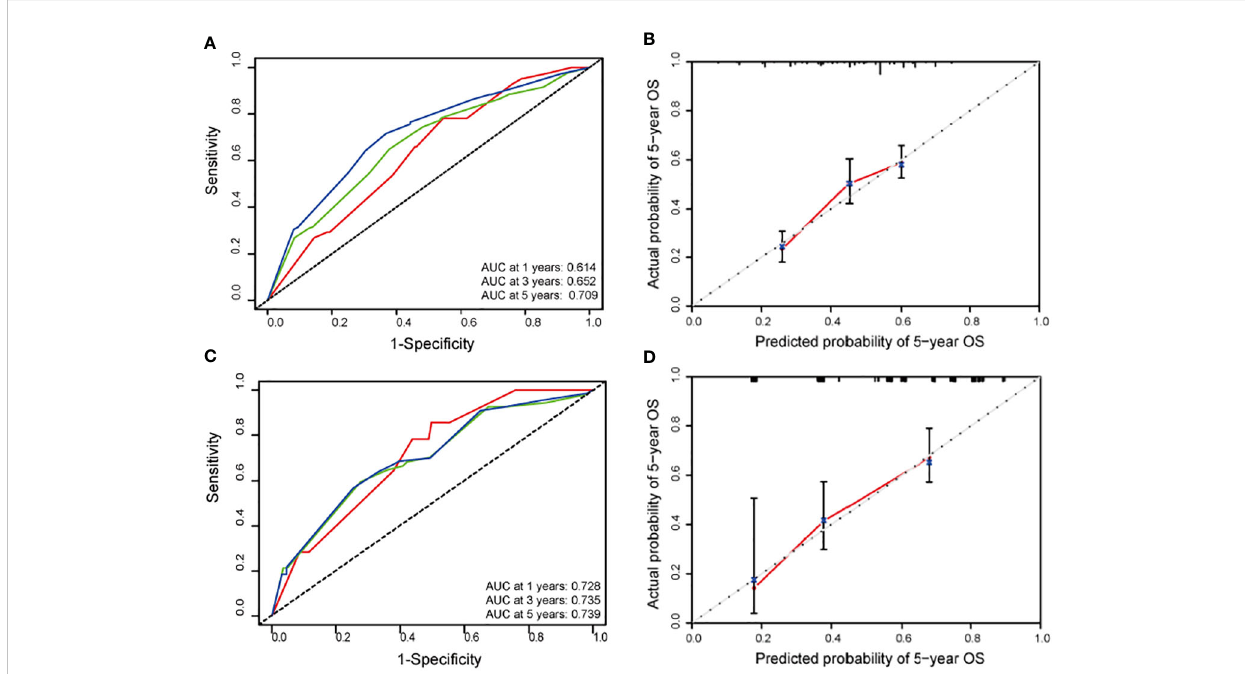
FIGURE 2 (A) Receiver operating characteristic (ROC) curves for 1-(red line), 3-(green line) and 5-year (blue line) overall survival (OS) according to the training cohort (TC) nomogram. (B) Calibration plot for predicting survival at 5-year in the TC nomogram. (C) ROC curves for 1-(red line), 3-(green line) and 5-year (blue line) OS according to the validation cohort (VC) nomogram. (D) Calibration plot for predicting survival at 5-year in the VC